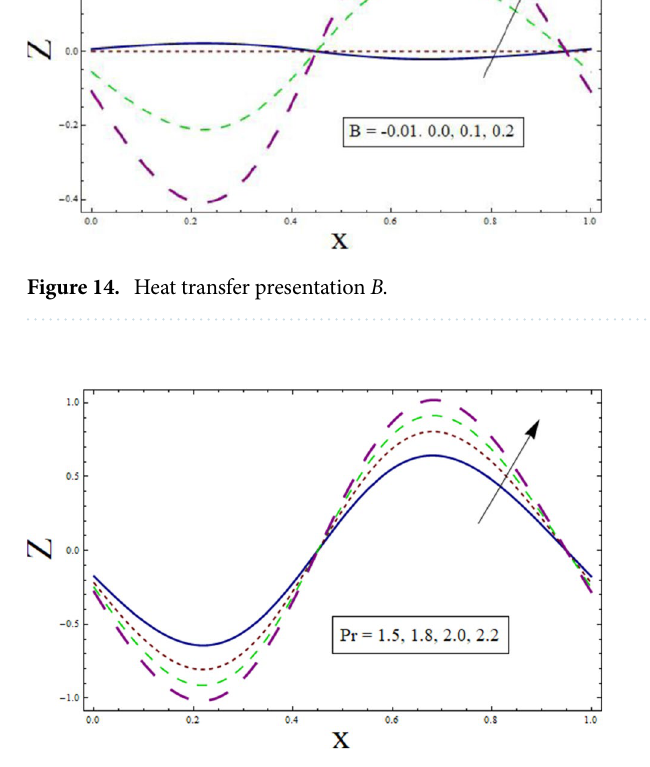
Figure 15. Heat transfer presentation Pr .